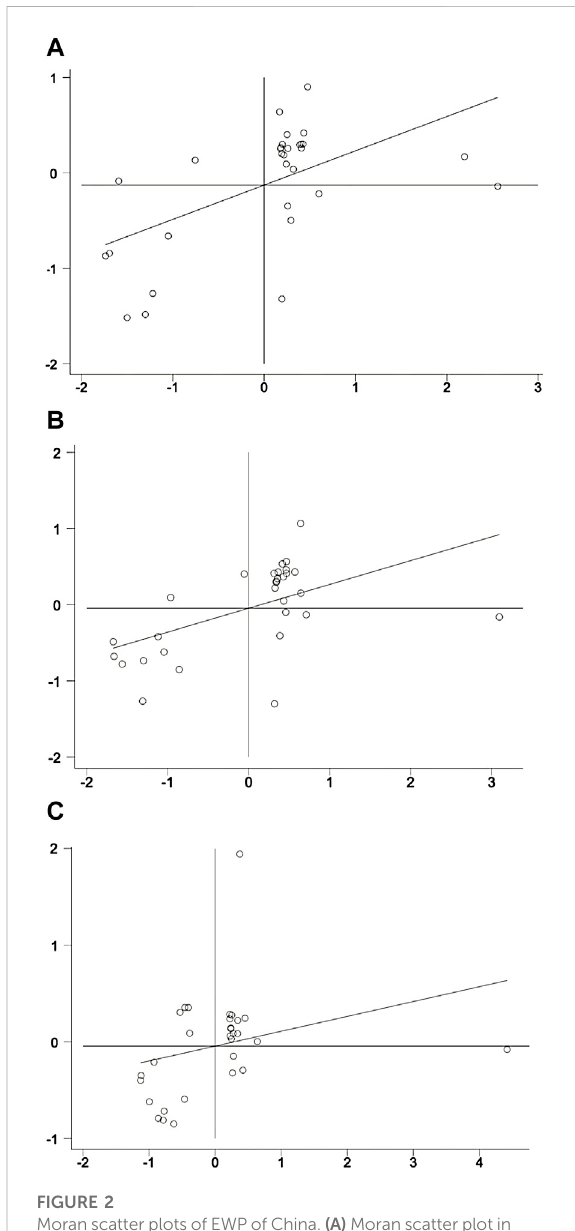
FIGURE 2 Moran scatter plots of EWP of China. (A) Moran scatter plot in 2008. (B) Moranscatterplotin2014. (C) Moranscatterplotin2019.